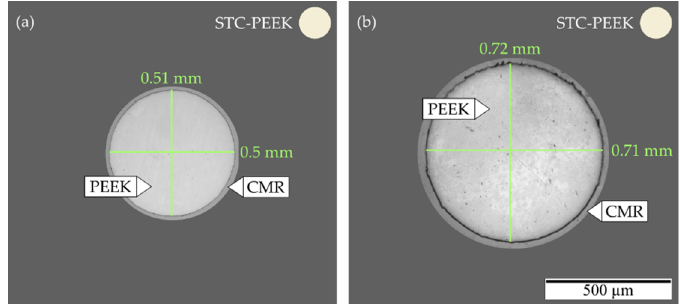
Figure 10. Photomicrographs of investigated specimens made of neat polymer manufactured by means of shrink tube consolidation (STC) embedded in cold mounting resins (CMR): ( a ) polyether ether ketone (PEEK), (cid:1830) = 0.45 mm; ( b ) PEEK, (cid:1830) = 0.65 mm.